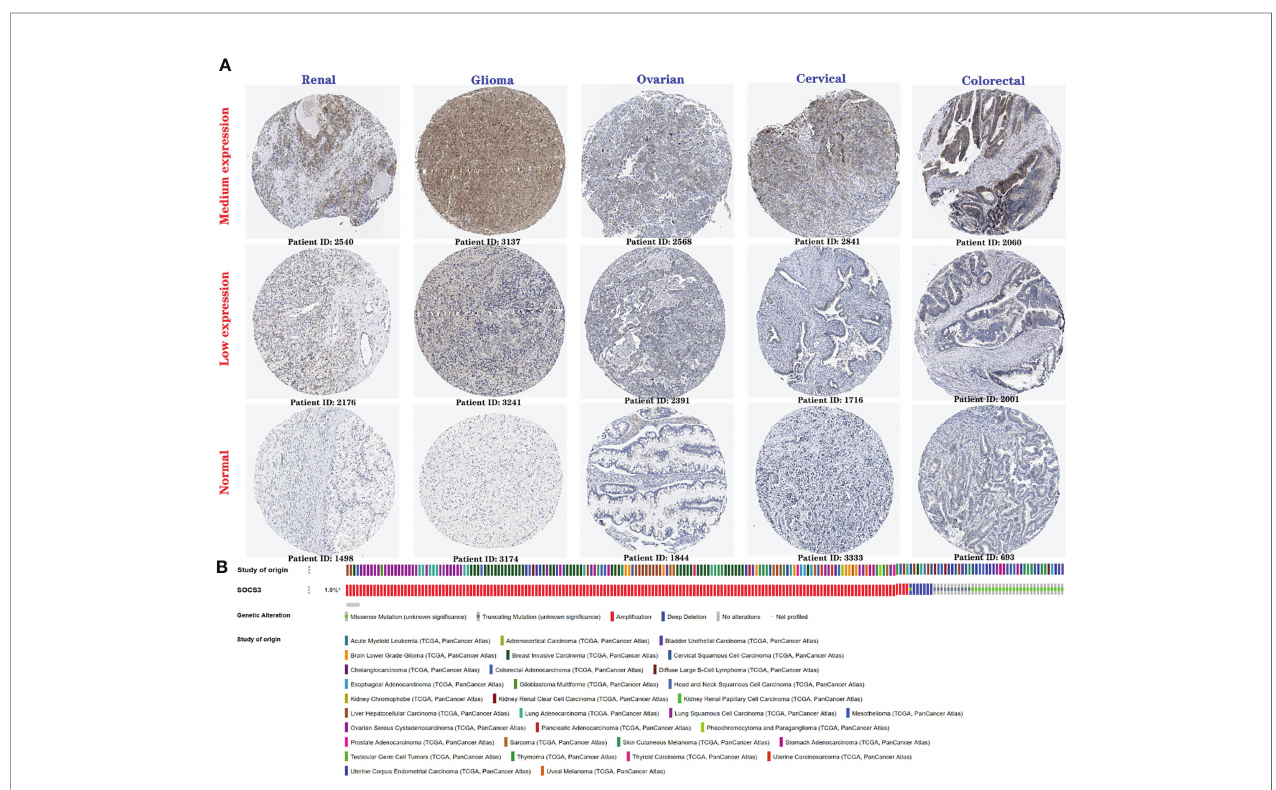
FIGURE 5 | Protein expression level and genetic alteration of SOCS3 in various cancers. (A) The protein expression of SOCS3 in different cancers (low expression and medium expression) and normal tissues via Human Protein Atlas website. (B) Genetic variations of SOCS3 in disparate cancers across OncoPrint. *altered/ pro fi